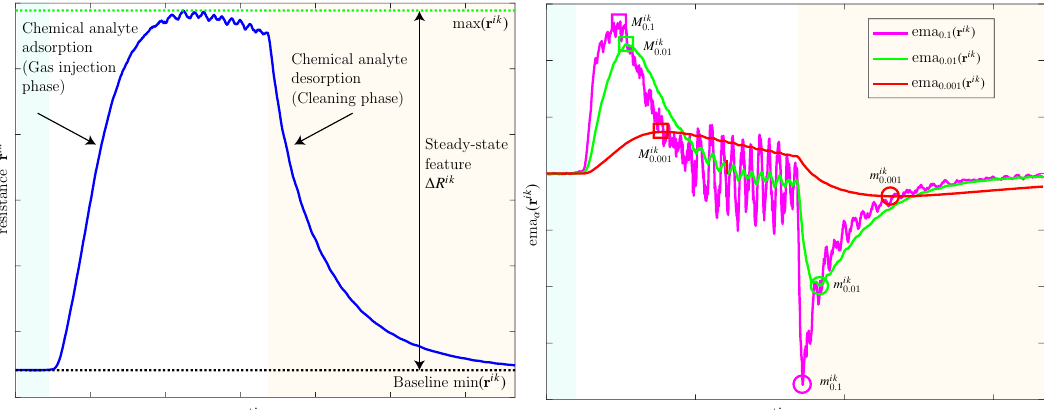
Figure 4. Illustration of the response of a sensor of an EN and its EMA signals. Data taken from dataset #2 resistance